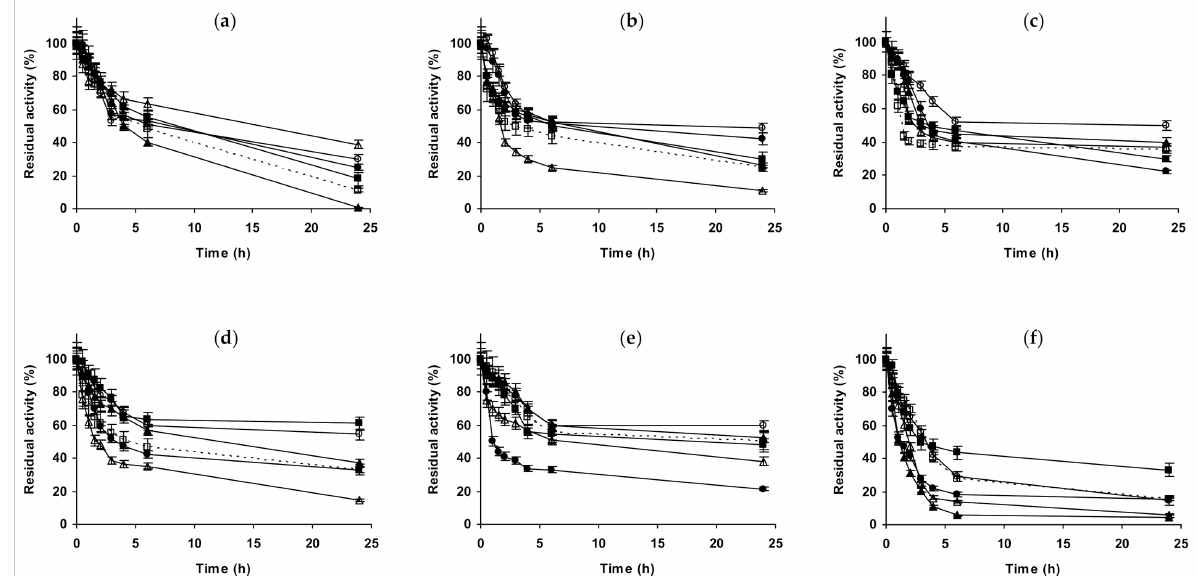
Figure 6. Effect of ionic strength and inactivation pH on the stability of different immobilized preparations of ficin. Glyoxyl- ficin: ( a ) pH 5.0 and 60 ◦ C; ( b ) pH 7.0 and 60 ◦ C; ( c ) pH 9.0 and 60 ◦ C. Glutaraldehyde-ficin: ( d ) pH 5.0 and 60 ◦ C; ( e ) pH 7.0 and 60 ◦ C; ( f ) pH 9.0 and 60 ◦ C. Other specifications are described in the Methods section. Dotted line, empty squares: references; full triangles: 1 M NaCl; empty triangles: 3 M NaCl; full circles: 1 M (NH 4 ) 2 SO 4 ; empty circles: 3 M (NH 4 ) 2 SO 4 and full squares: 1 M Na 2 SO 4